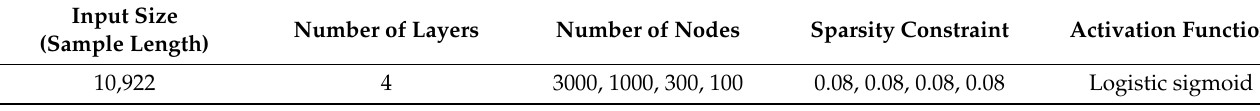
Figure 11. The training time consumption of SSA-DNN architectures with different numbers of hidden layers and nodes in them.